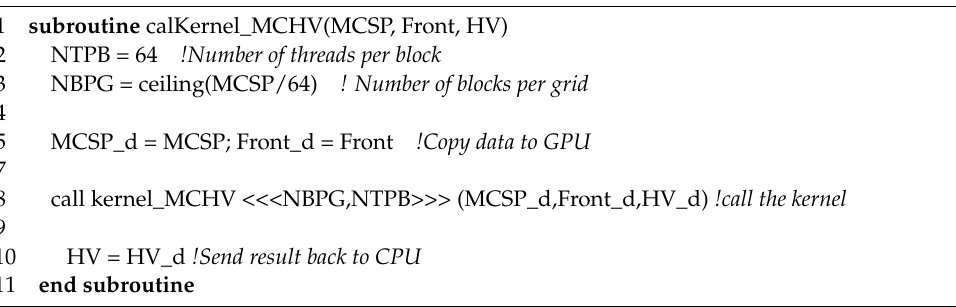
Algorithm 3. Code snippet of the CPU subroutine for calling kernel _